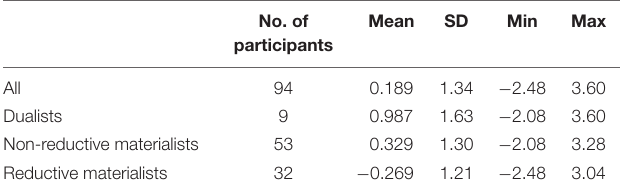
TABLE 3 | Descriptive statistics of self-transcendence within each category of mind-body inclination.